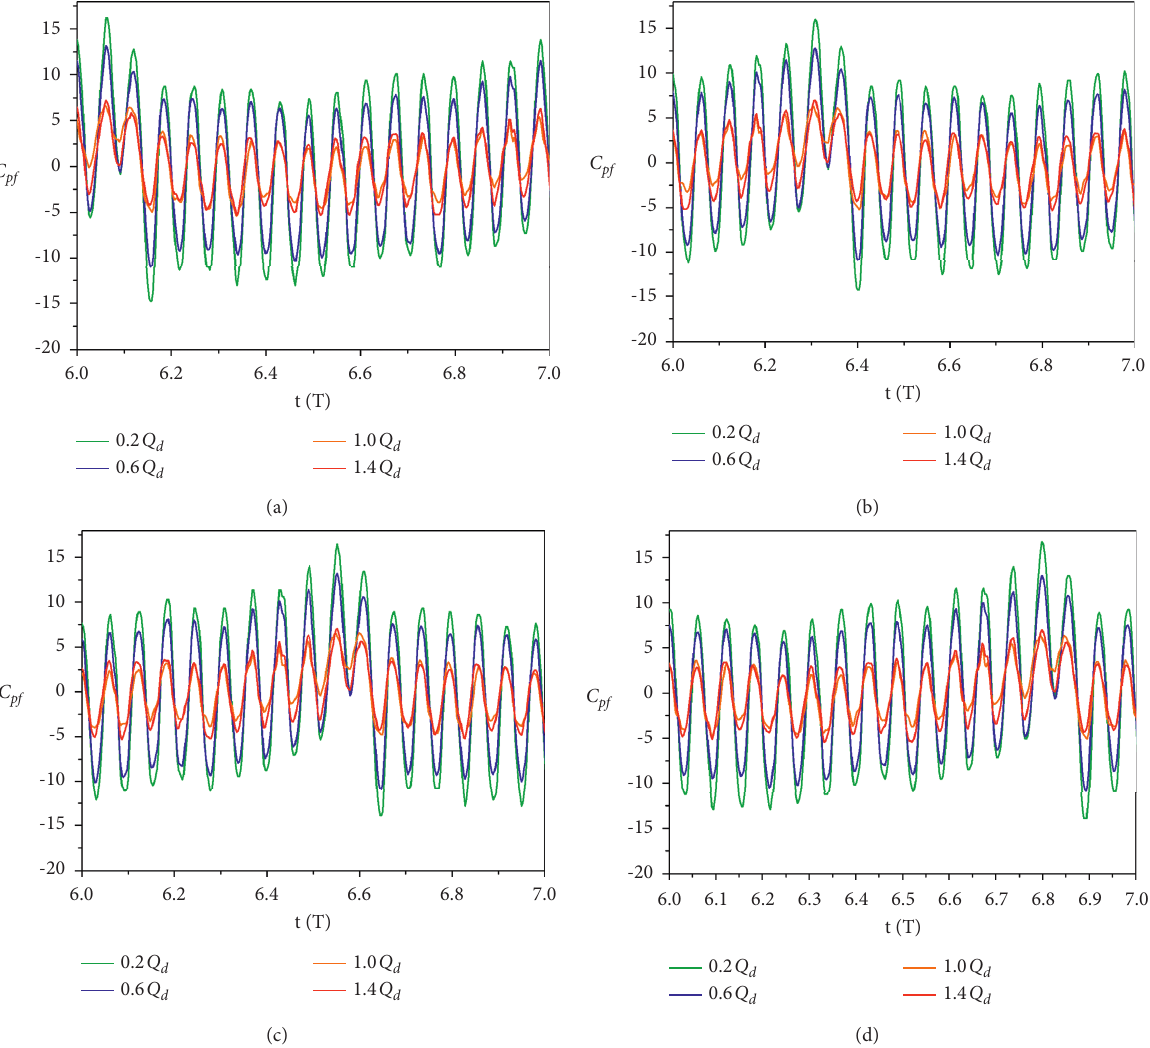
Figure 13: Pressure signals at the time domain of the diffuser at the impeller with different flow rates for monitoring points: (a) 7, (b) 8, (c) 9, and (d)